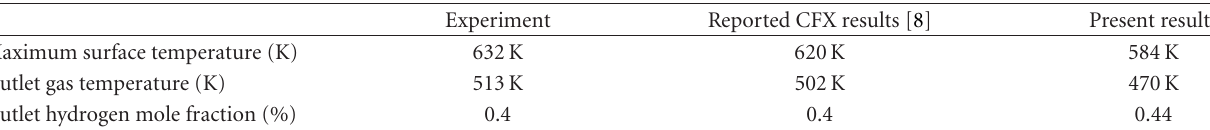
Table 1: Comparison of results for first steady-state condition (At inlet mixture temperature 355K, mole fraction of hydrogen 2.93%, and mole fraction of steam 30% steam) for Gx-test series.